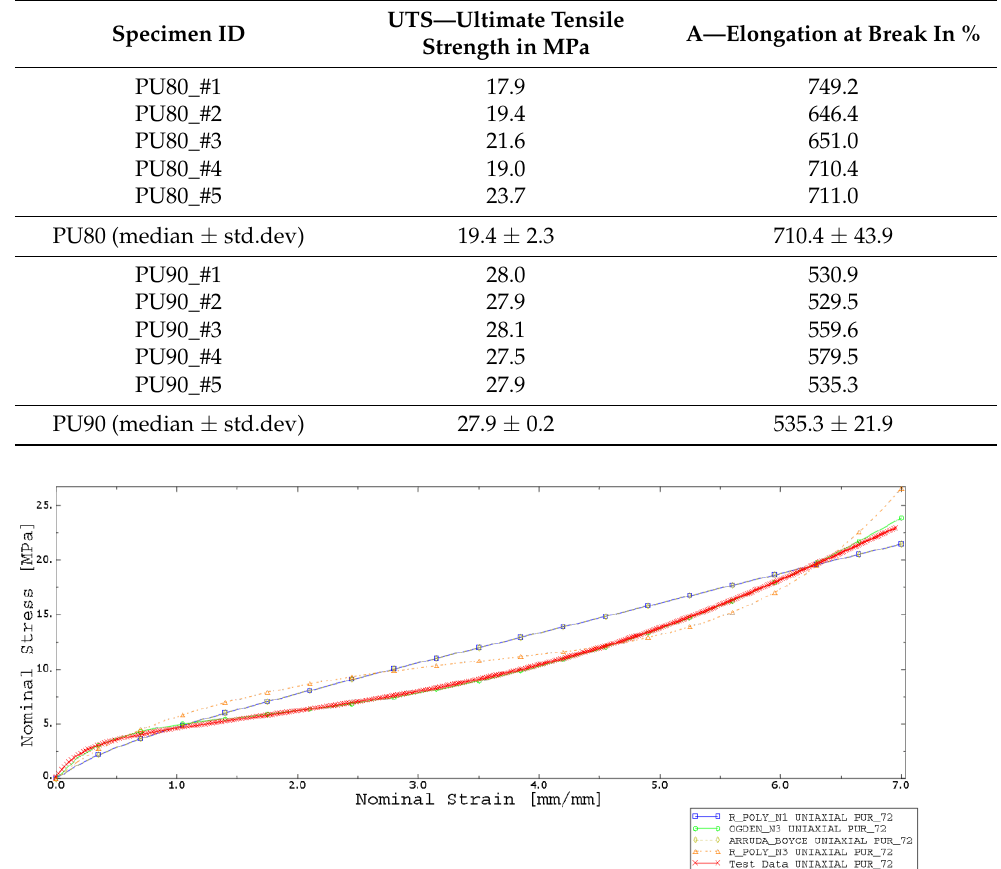
Table 1. Tensile test results analysis for 80 ShA and 90 ShA material configuration.